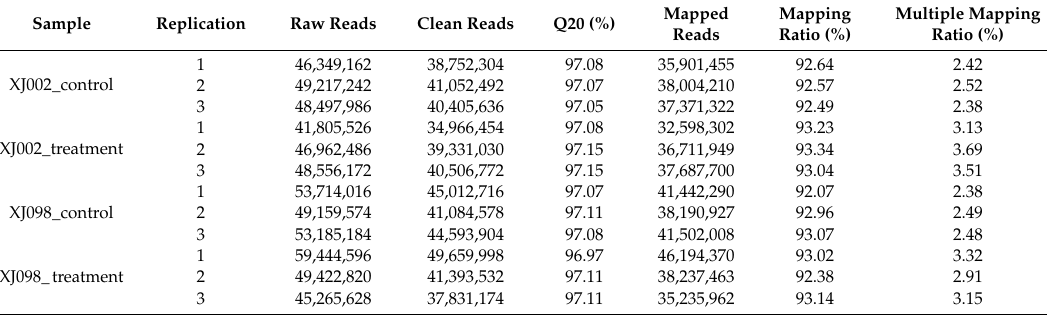
Table 1. Summary of the sequence data from RNA